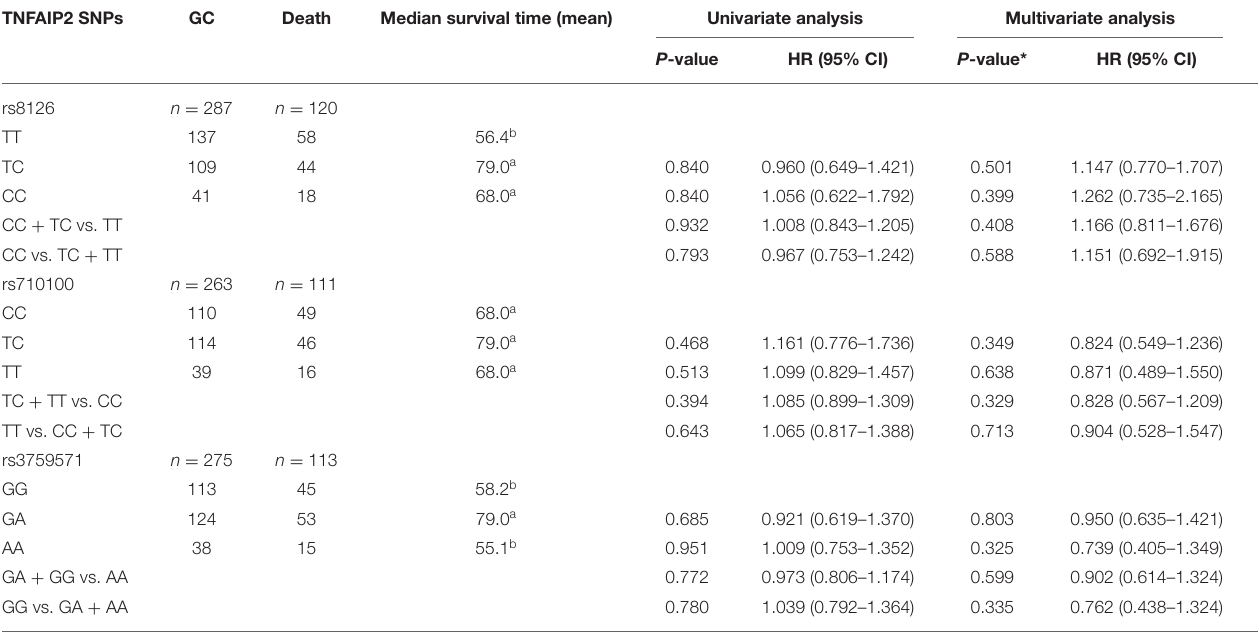
TABLE 6 | The correlation between TNFAIP2 SNPs and gastric cancer (GC) prognosis in the general analysis. TNFAIP2